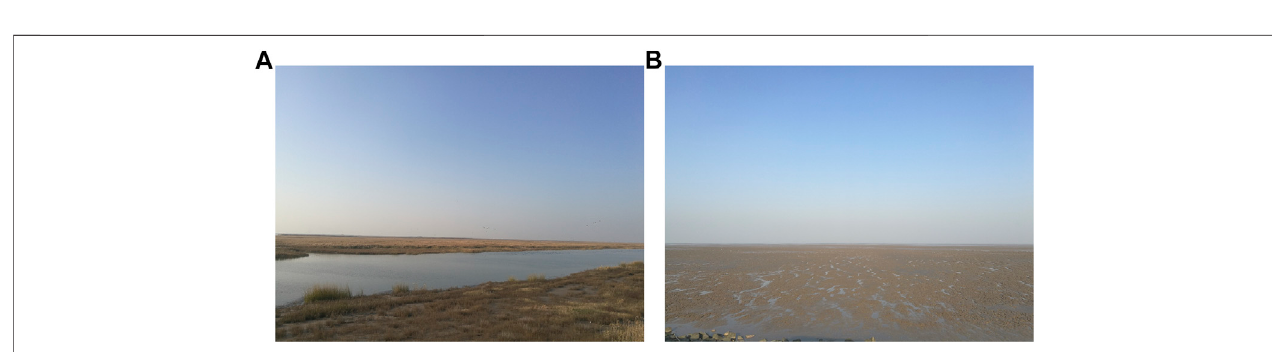
FIGURE 2 | The Dongtan wetland landscape of Chongming Island: (A) Arti fi cial wetland inside the new sea dike built in 2015 (see the text for explanation); and (B) intertidal fl at outside the new sea dike (natural wetland, including salt marsh and mud fl at). Photographs taken by the authors, April 2018.